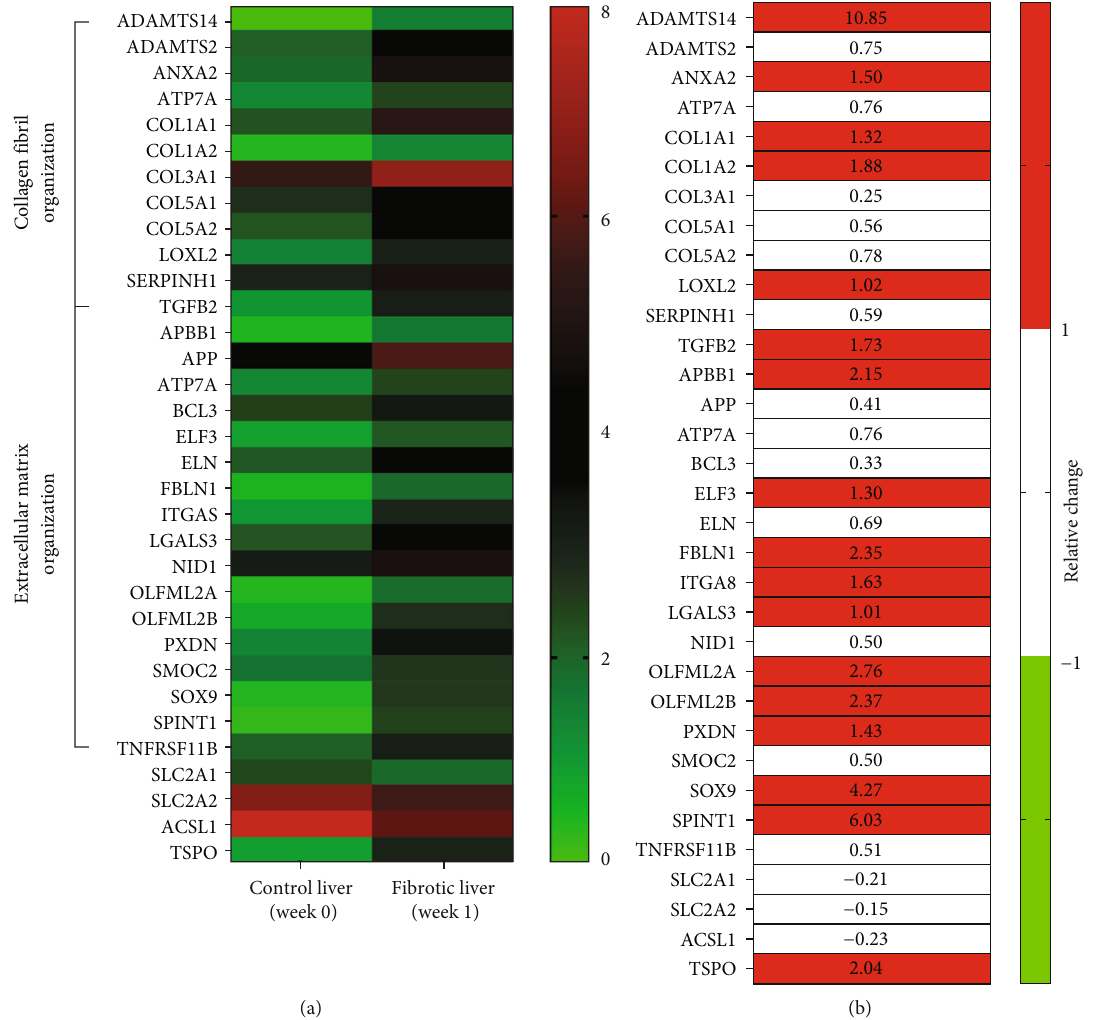
Figure 4: The next-generation sequencing analysis. (a) The heat map revealed the distinct ribonucleic acid (RNA) expression pro fi les between control (week 0) and fi brotic liver (week 1). The color bar indicates the range of expression values from 0 (green) to 8 (red). (b) The di ff erence between normal and fi brotic livers. The color bar indicates the relative change more than 1 (red) or less than 1 (green) for the fi brotic liver with respect to the control liver ( ð fibrotic − control Þ /control Þ . The list of abbreviations is in supplementation information (Table